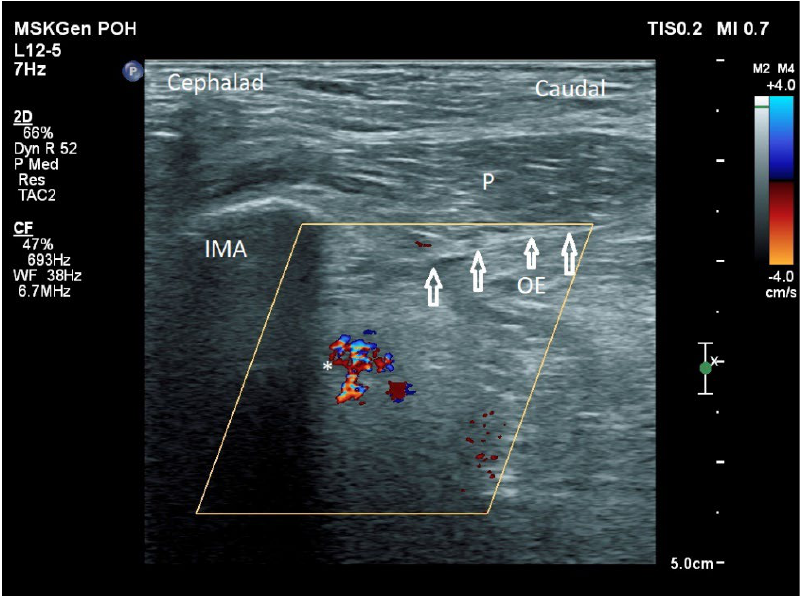
Figure 7. Approaching the ONAB in a sagittal plane from a caudal to cephalic direction . IMA: inferomedial acetabulum, P: pectineus, OE: obturator externus, *: acetabular and/or posterior branch of the obturator artery, white hollow arrow: needle.